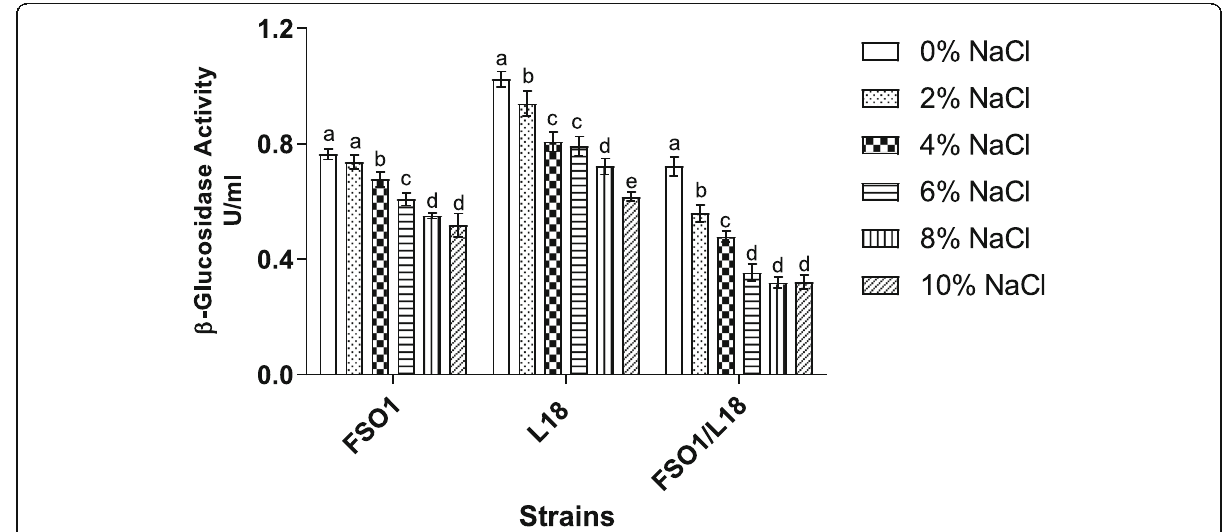
Fig. 9 β -Glucosidase activity produced by strains FSO1, L18 and FSO1/L18 after 7 days of culture at 30 °C in MRSm adjusted to different initial NaCl concentrations (Legend: MRSm: MRS containing oleuropein (1%) as a sole carbon source, FSO1: L. plantarum FSO1, L18: C. pelliculosa L18, FSO1/L18: combination of FSO1 and